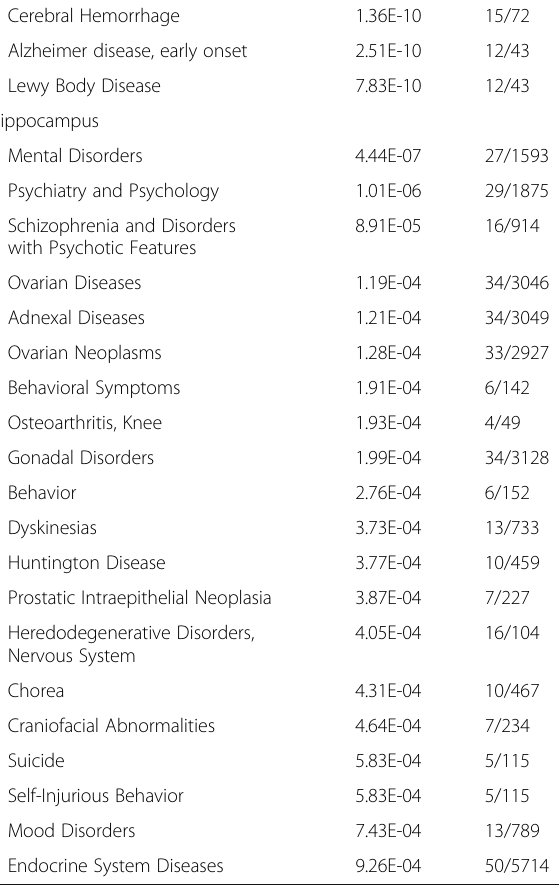
Table 1 Top 20 diseases affected by EA stimulation at ST36 in brain tissues